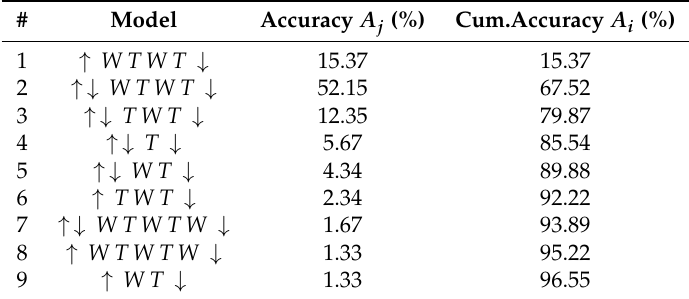
Table 6. Included models and the resulting recognition accuracy, as well as the cumulative accuracy. The order of the activities for each model is listed in following terms: sit-to-stand ( ↑ ), Walk (W), Turn (T), stand-to-sit ( ↓ ).